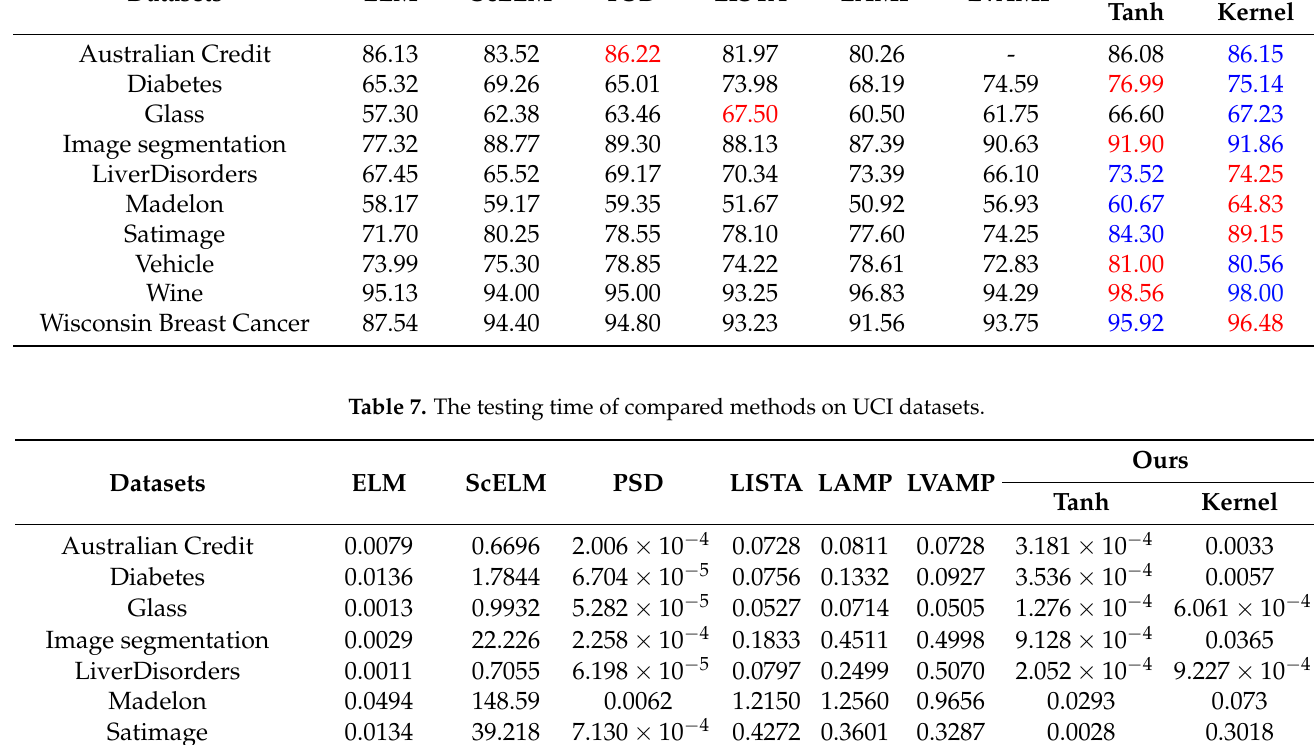
Table 6. The average accuracy of compared methods on UCI datasets (red is the best result and blue is the second one). Datasets